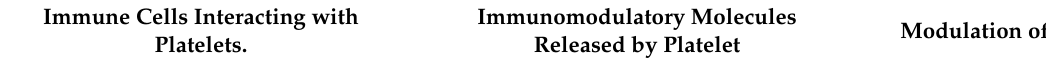
Table 2. Platelets as modulators of immune cell responses. Immune Cells Interacting with